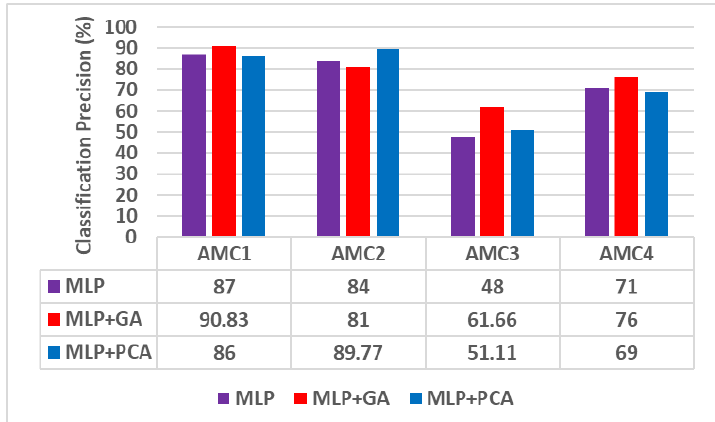
Figure 6. Comparative results of the RFI classification results with considering BS = 1 and HLN = 30 MLP (with all features), MLP + GA ( NoF = 5) and MLP + PCA ( NoF =